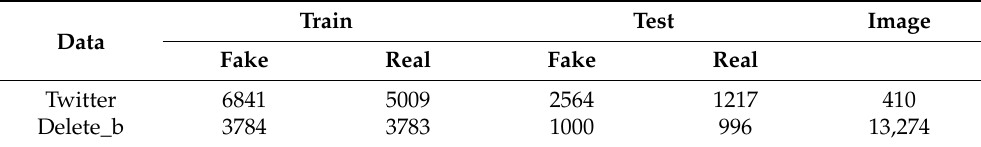
Table 2. The dataset used in the experiment.